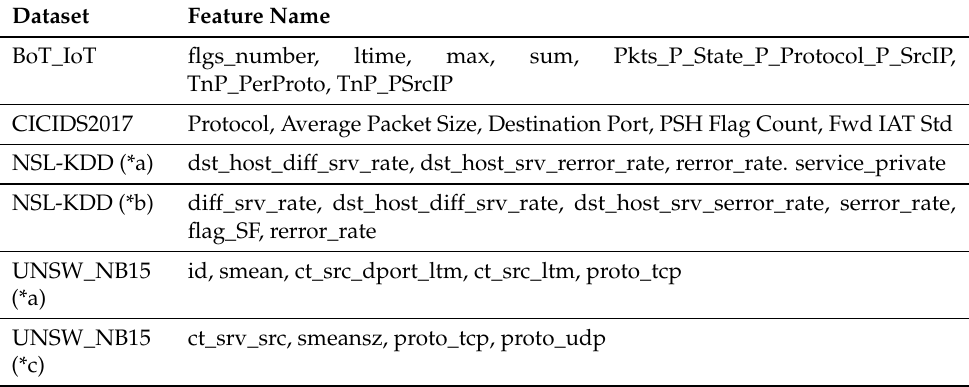
Table 5. Top features identified by six or more